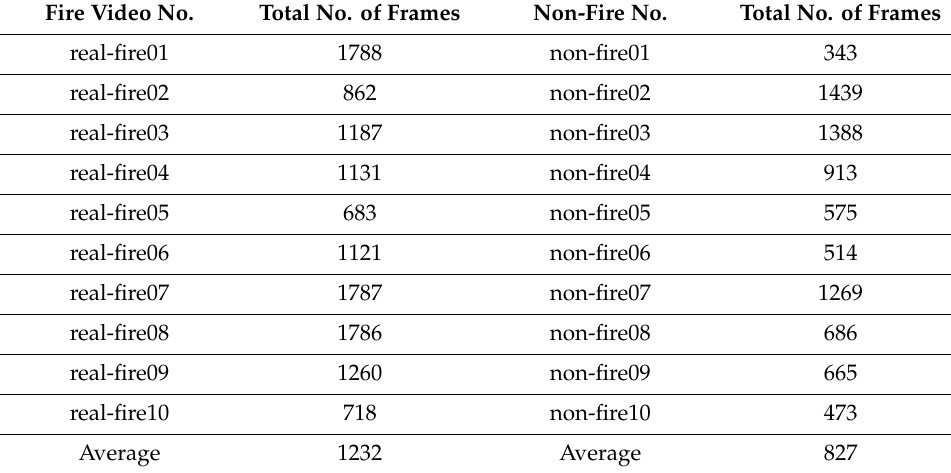
Table 1. Configuration of test video sequences including fire and non-fire videos. Fire Video No. Total No. of Frames Non-Fire No. Total No. of Frames